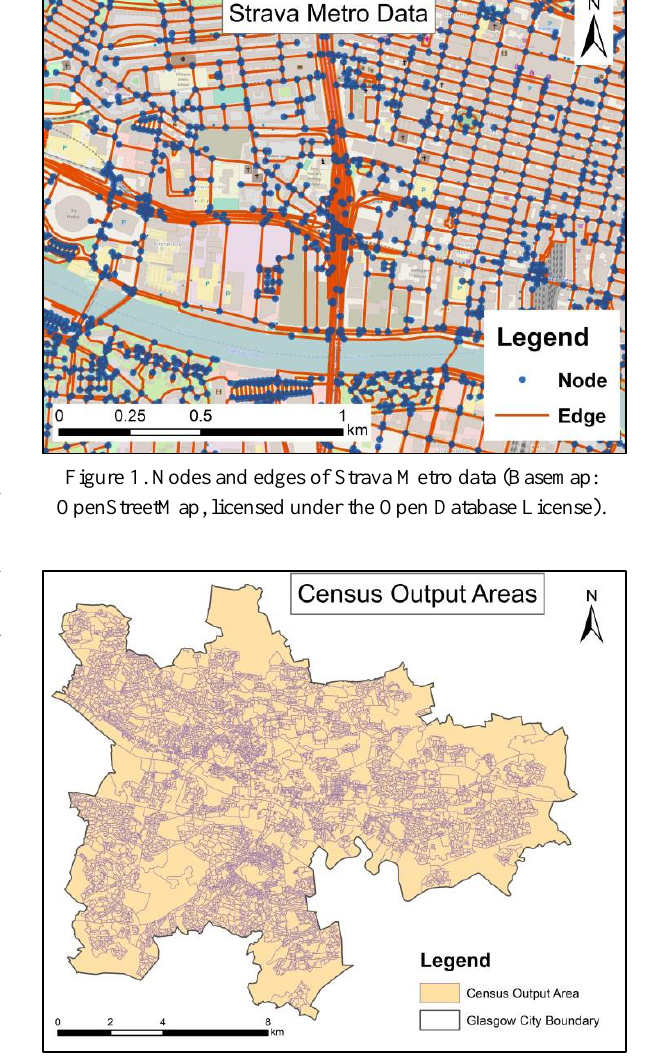
Figure 2. Census output areas in Glasgow.